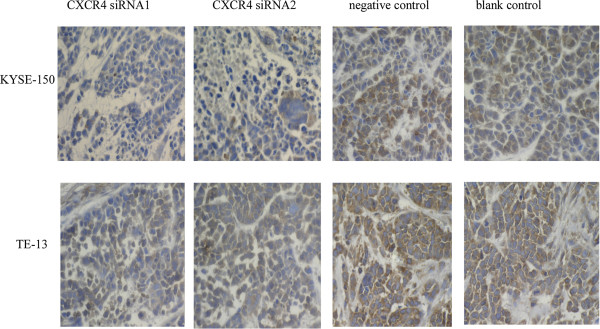
CXCR4 siRNA inhibited significant CXCR4 protein expression. The expression of CXCR4 protein was observed with the immunohistochemical SP staining. The positive color is brown particles.